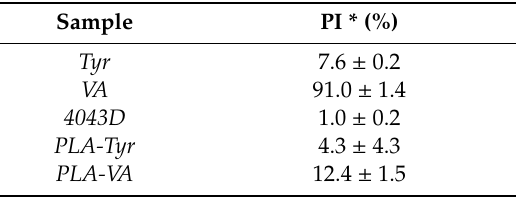
Table 3. DPPH values of initiator and of synthesised